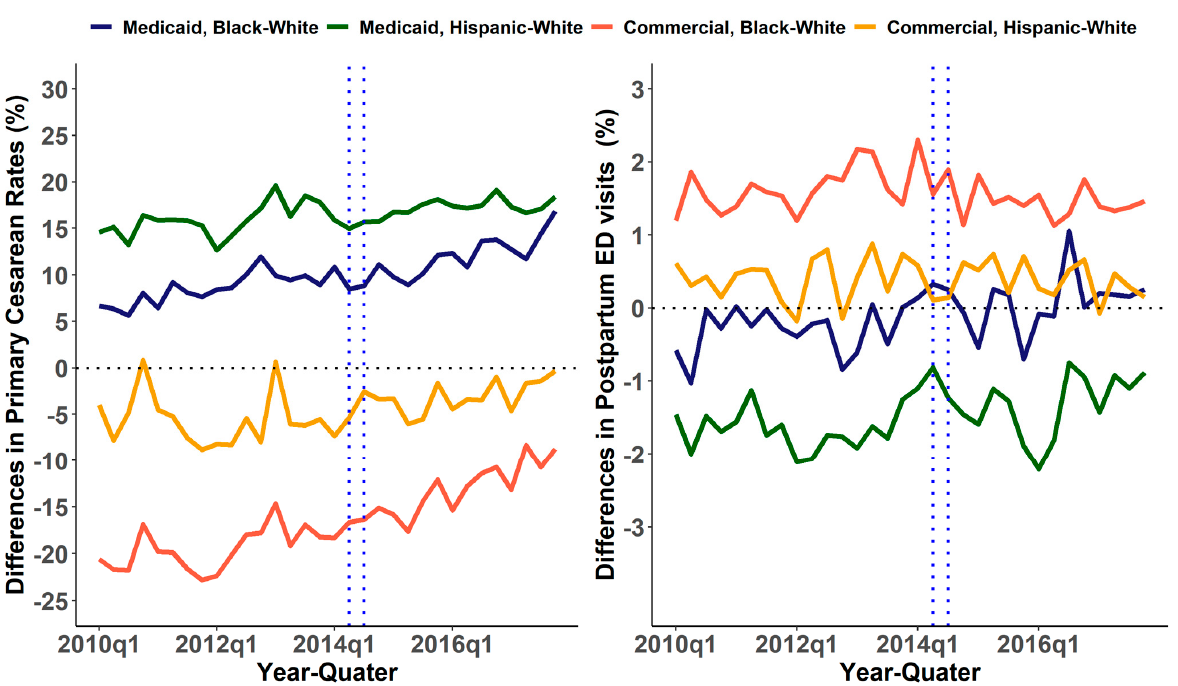
Figure 2. Disparities in primary cesarean rates and postpartum ED visits between non-Hispanic white and non-Hispanic African American and non-Hispanic white and Hispanic patients with Medicaid or commercial insurance.